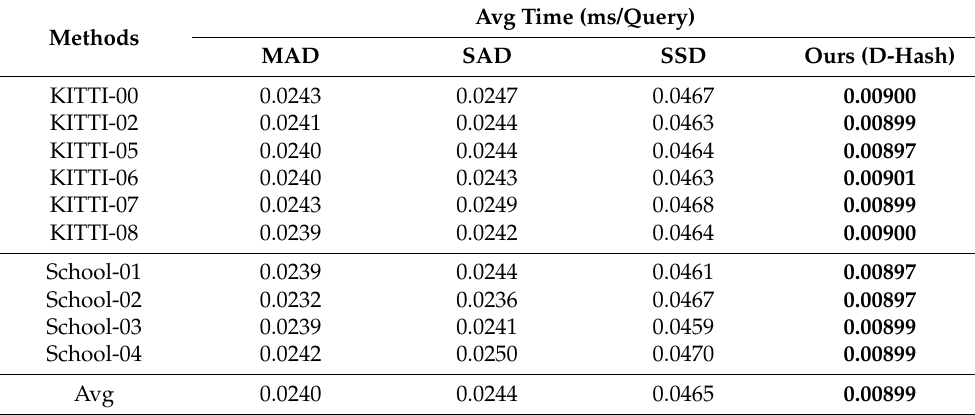
Table 5. Time comparison of different distance functions in the actual loop closure